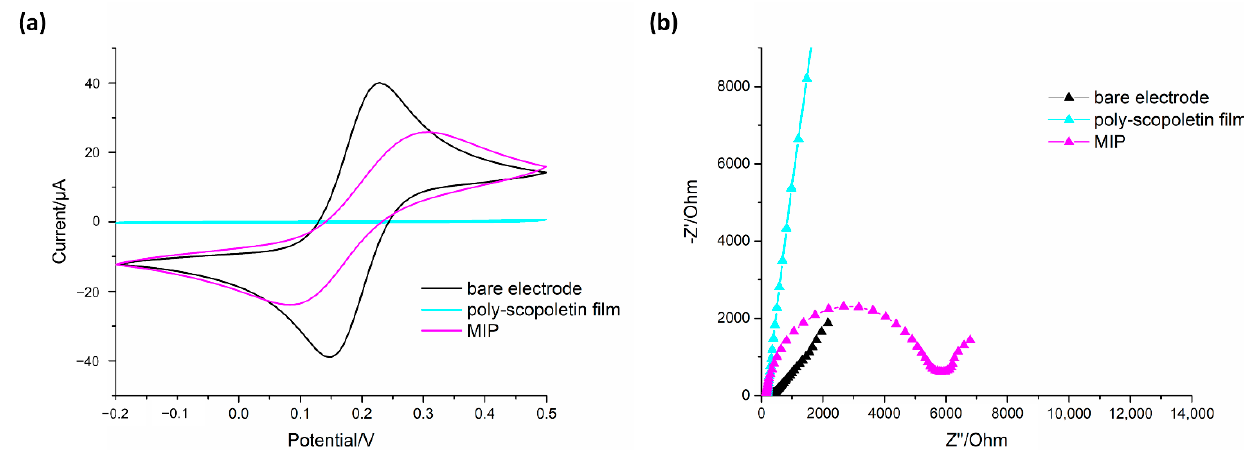
Figure 2. ( a ) Cyclic voltammograms (scan rate 100 mV/s) and ( b ) EIS Nyquist plots recorded in 5 mM [Fe(CN) 6 ] 3 − / 4 − redox couple prepared in 50 mM phosphate buffer with KCl 0.1 M, to check template removal after washing treatment of MIP 1 . “Polyscopoletin film” and “MIP” refer, respectively, to polymer before and after washing for lysozyme removal.